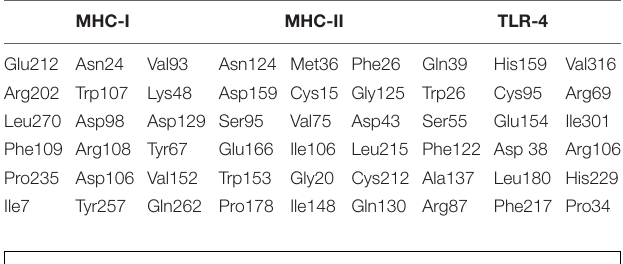
TABLE 6 | Vaccine constructs interactions with different immune receptors.